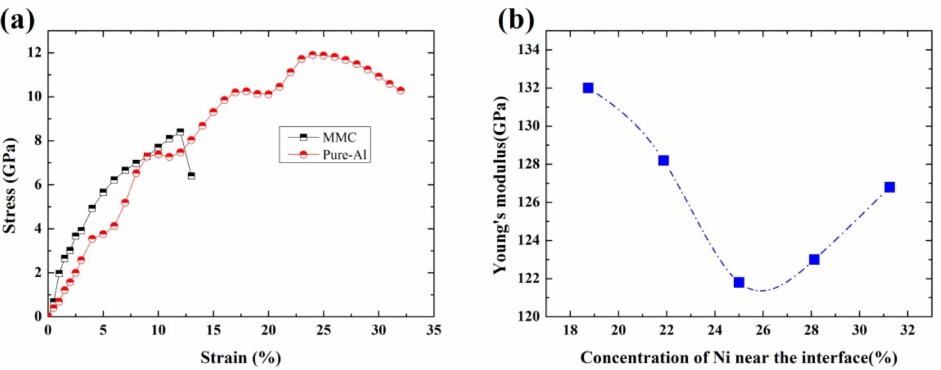
Figure 7. ( a ) The computed strain-stress curves for AlCoCrFeNi HEA reinforced AMCs and pure aluminum, ( b ) Young’s modulus of AMCs against the Ni concentration in the interfacial